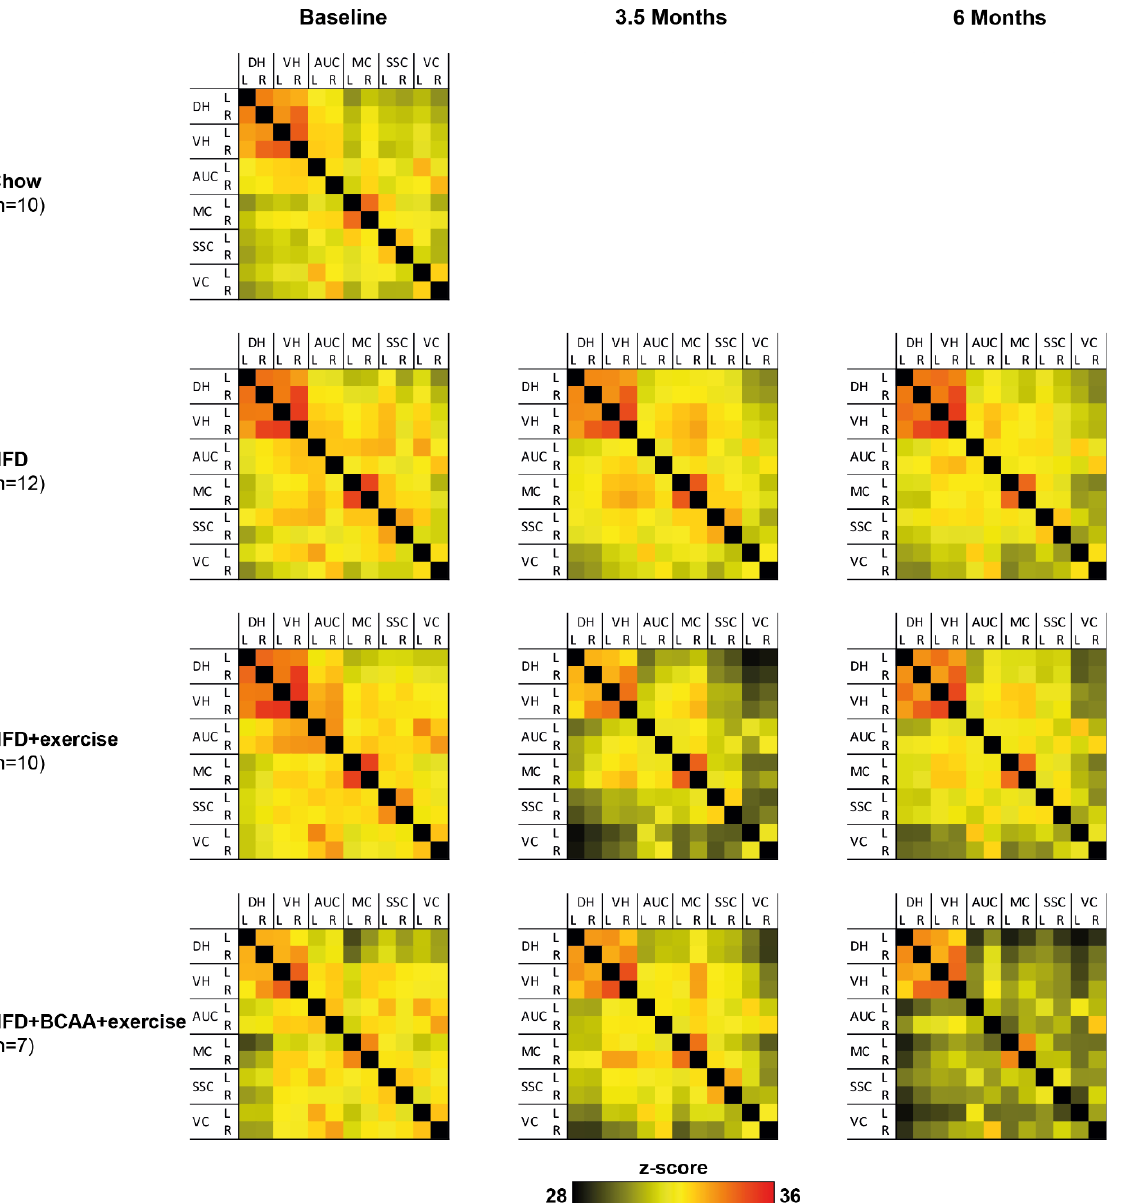
Figure 7. Resting-state functional connectivity based on total correlations. Functional connectivity between brain regions was measured using resting-state fMRI at baseline (chow) and after 3.5 and 6 months of treatment with HFD, HFD + exercise, and HFD + BCAA + exercise. Total correlation matrixes show the connectivity between the dorsal hippocampus (DH), ventral hippocampus (VH), auditory cortex (AC), motor cortex (MC), somatosensory cortex (SSC), and visual cortex (VC) for the left (L) and right (R) hemisphere, respectively, at each neuroimaging time point, respectively. High-fat diet (HFD), branched-chain amino acids (BCAA).